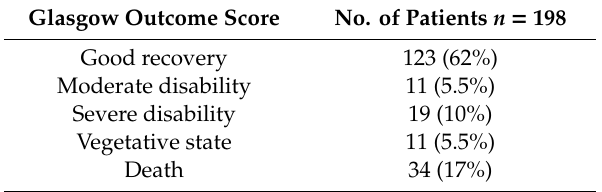
Table 1. Resultsoftreatmentintheseriesforallpatients; GlasgowOutcomeScore(GOS)afterthreemonths. Table 1. Results of treatment in the series for all patients; Glasgow Outcome Score (GOS) after three Glasgow Outcome Score months.